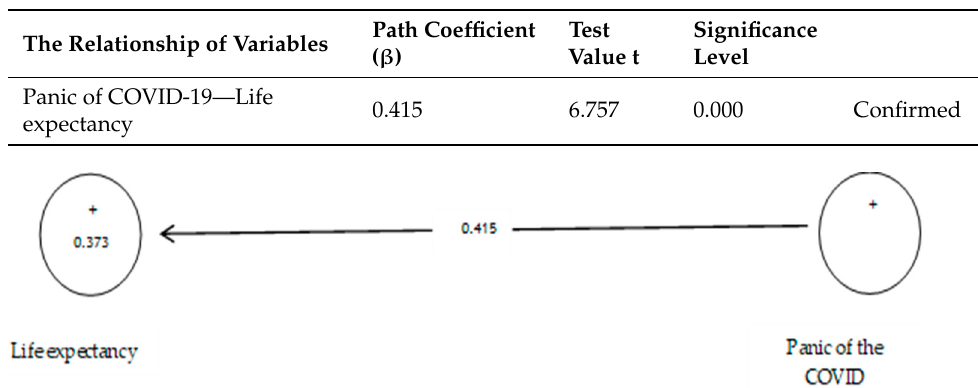
Table 11. Evaluation indicators of the internal model of the research, direction and significance of direct effects.